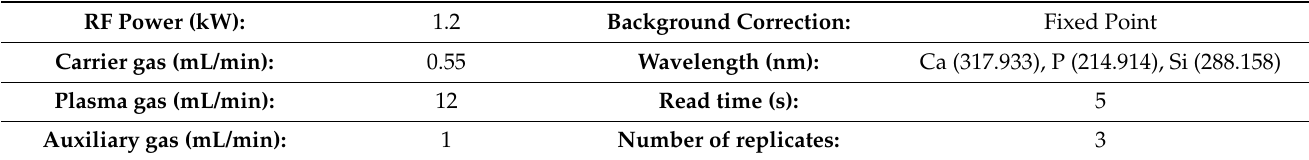
Table 1. Operating conditions of the inductively coupled plasma optical emission spectrometry (ICP OES) analysis in an axial viewing